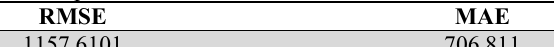
Result of MAPE, RMSE and MAE using Multilayer Perceptron MAPE